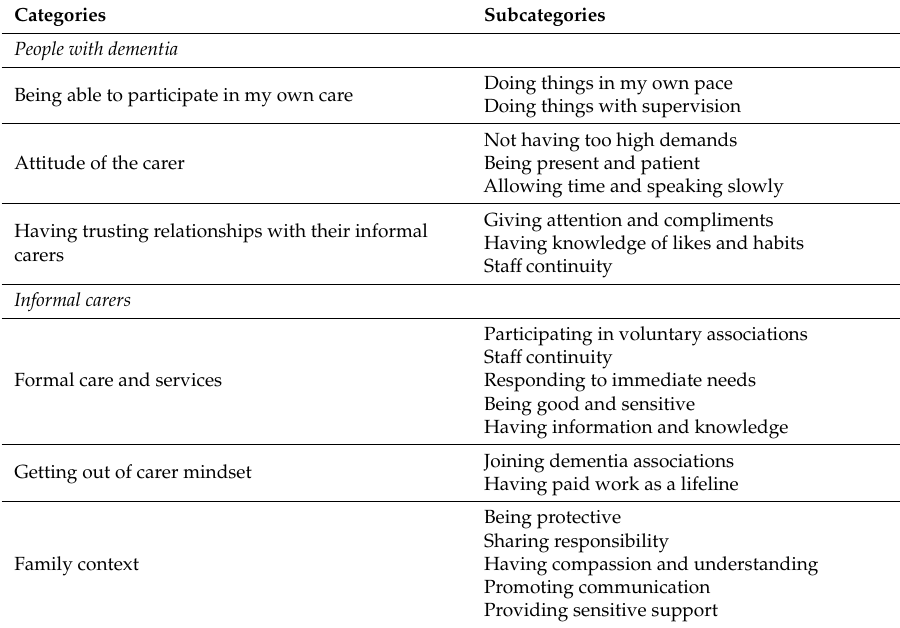
Table 3. Categories and subcategories describing needs and expectations of people with dementia and informal carers when receiving or giving care and support at